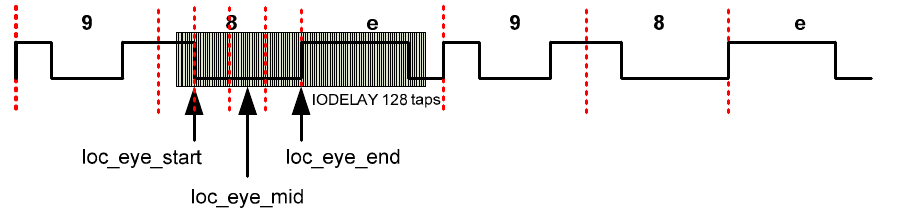
Figure 8. Bit calibration using IODELAYE2 component.